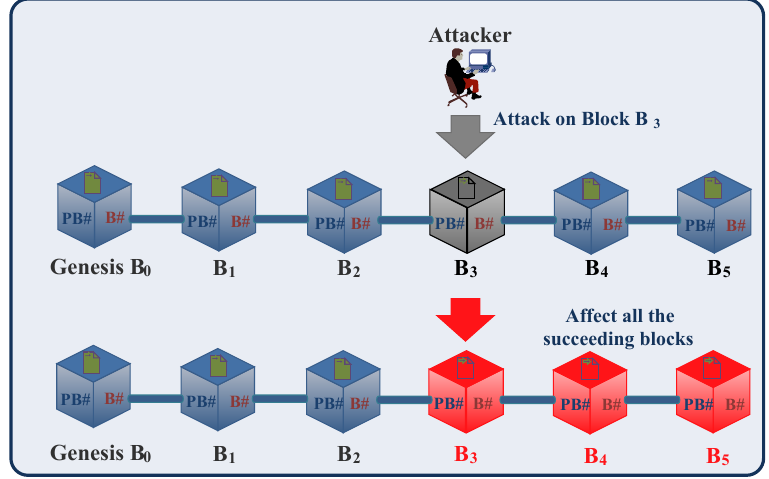
Figure 3. Immutability.